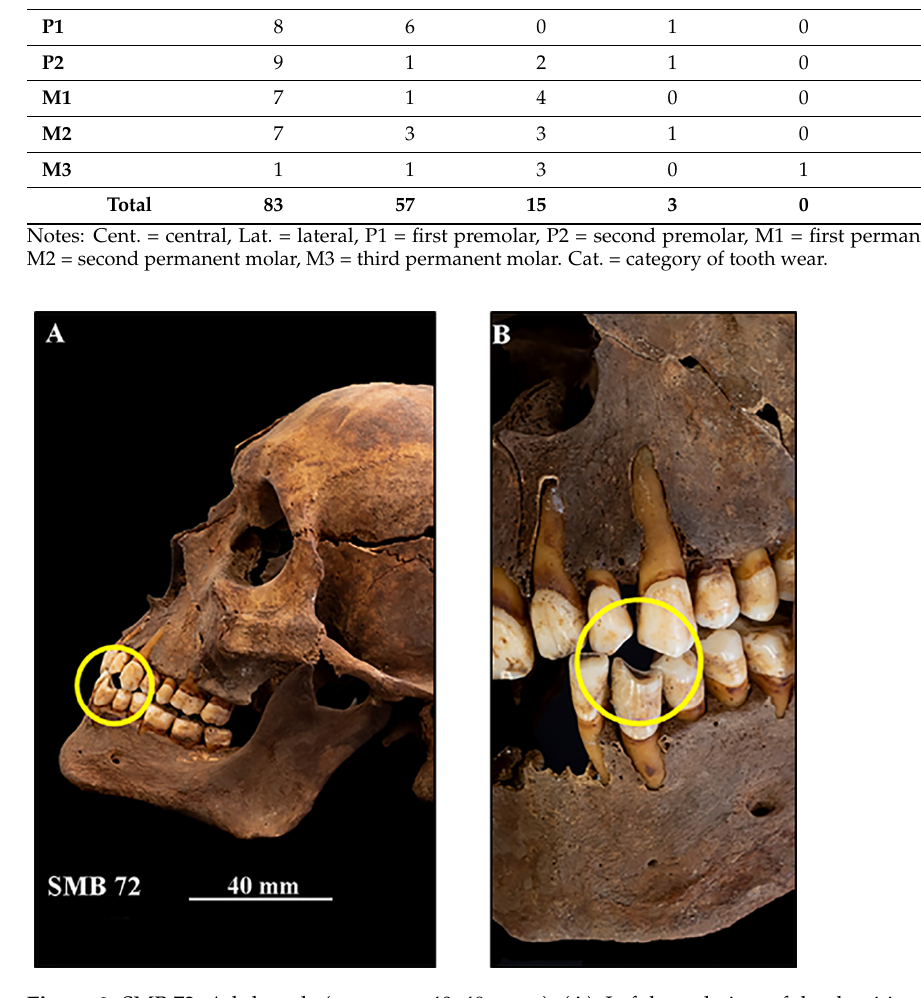
Figure 2. SMB 72. Adult male (age range 40 – 49 years). ( A ): Left lateral view of the dentition in situ in the skull. Yellow circle highlights a pattern of tooth wear often referred to as a ‘pipe notch’. The teeth have become worn from the movement of and holding a smoking pipe between the teeth over an extended period of time. ( B ): A close-up view of the left maxillary and mandibular permanent lateral incisors and canines opposing each other. The yellow circle shows a clear semi-circular tooth wear pattern. © Angela